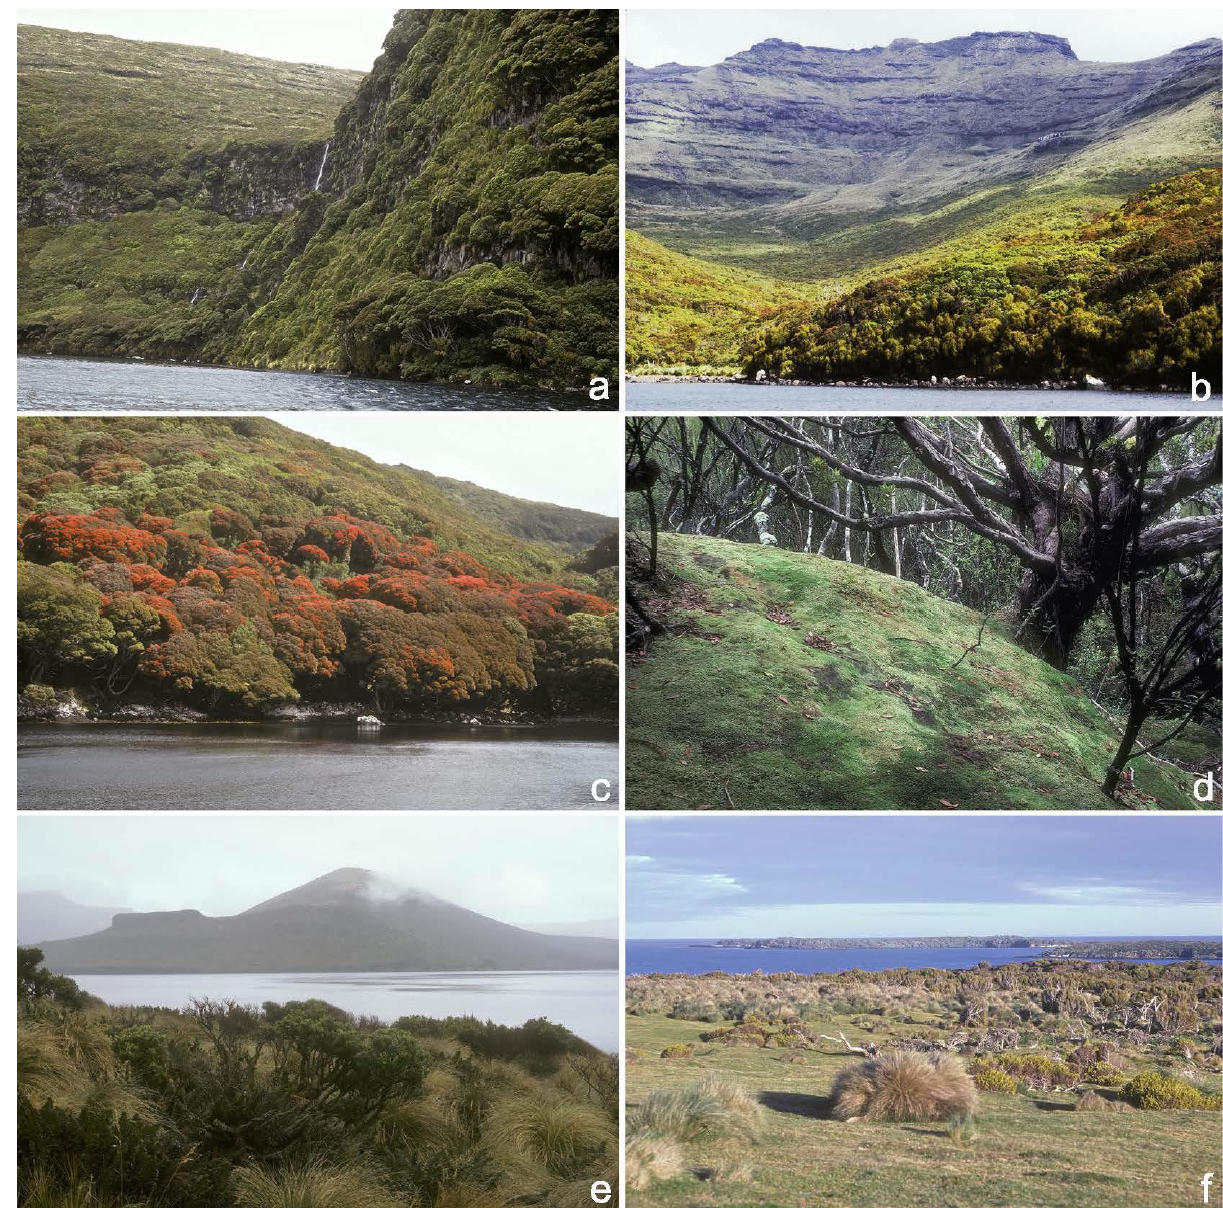
Figure 1. Landscapes, Auckland Island Group: ( a ) West coast sounds, Auckland I.; ( b ) East coast sounds, Auckland I.; ( c ) Rata forest ( Metrosideros umbellata ), Auckland I.; ( d ) Rata forest, interior, Auckland I.; ( e ) Hills in Carnley Harbour, Auckland I.; ( f ) Ocean and Ewing islands, viewed from Rose I. (All photographs courtesy of Adrian Plant).